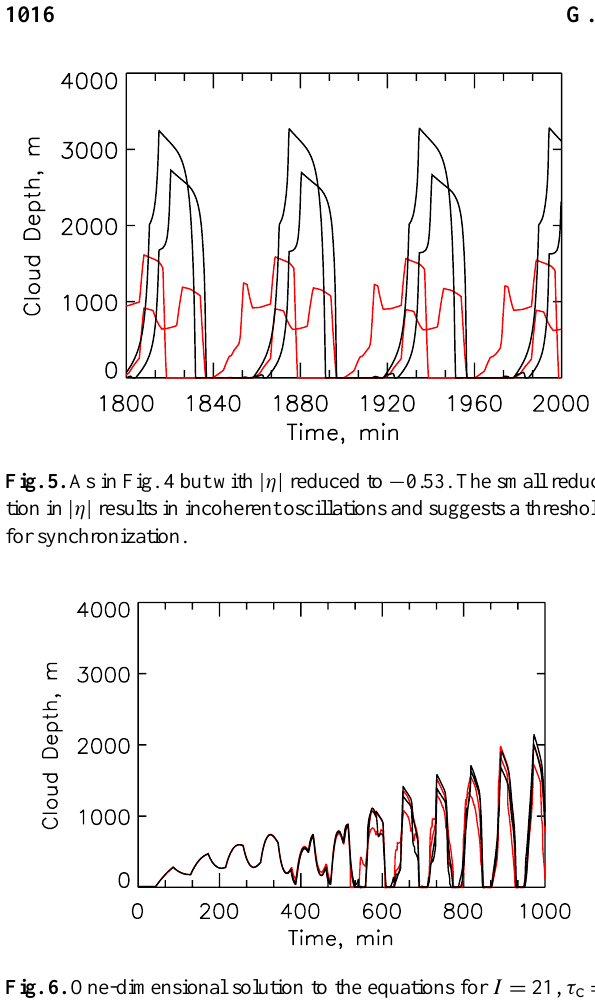
400 minoscillatorsareinphase butafterthatareincoherent; ∼